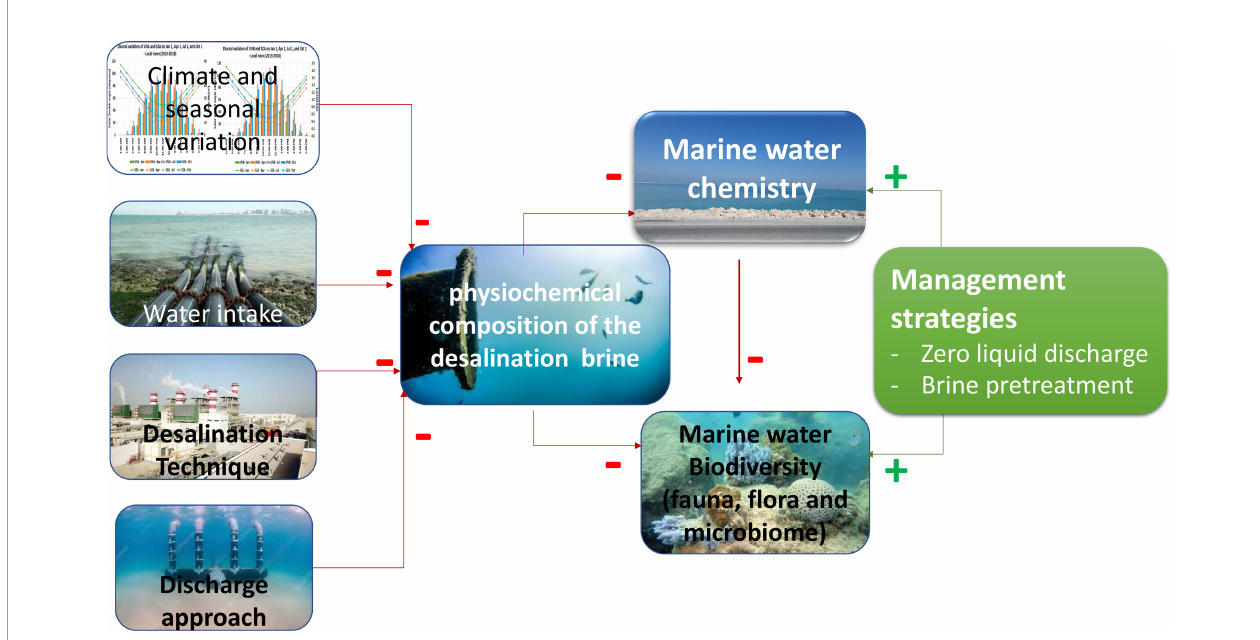
FIGURE 4 | Overview of the factors in fl uencing the desalination brine characteristics, and brine impacts and management